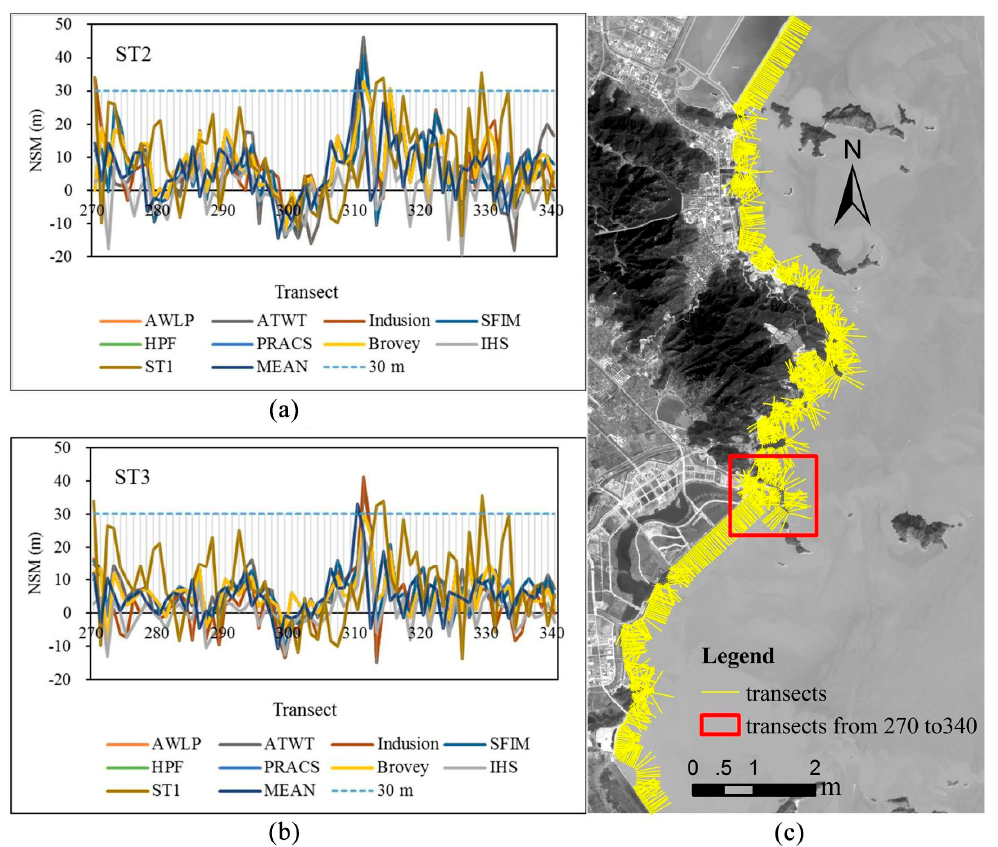
Figure 10. Results of figure for different images from transect 270 to 340 and the location of the transects. ( a ) NSM of strategy 2; ( b ) NSM of strategy 3; ( c ) position of selected transects.